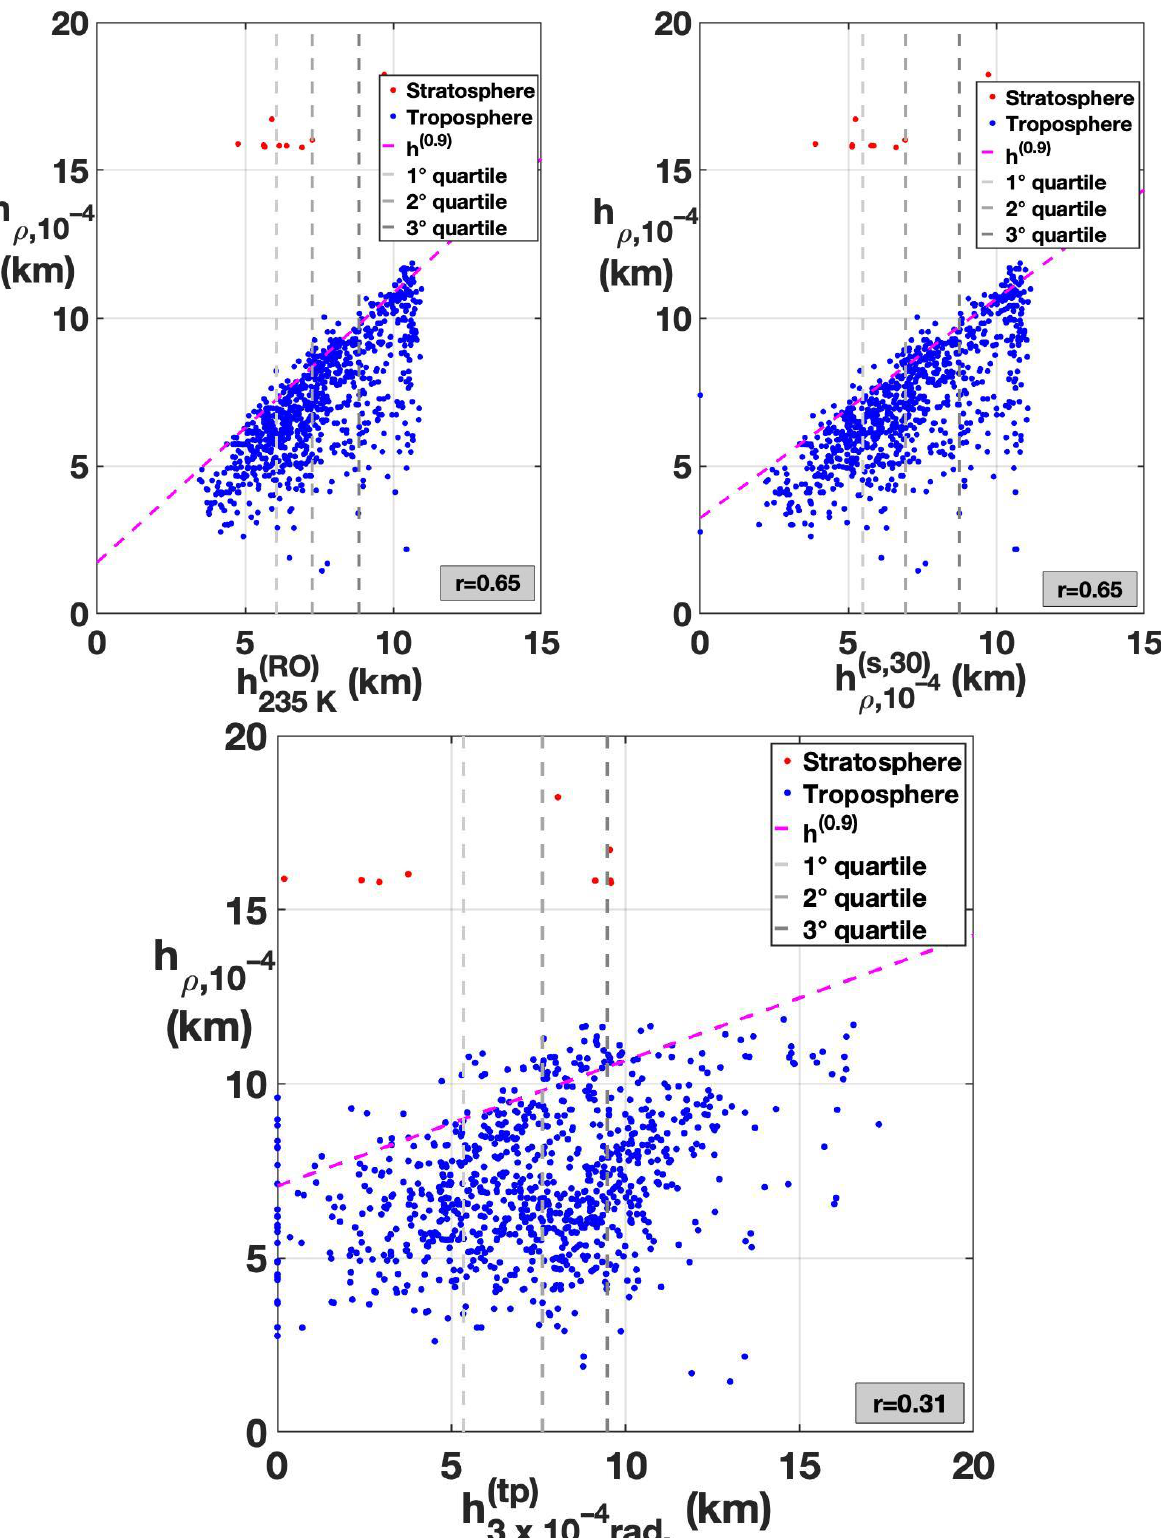
( RO ) ( top left ), 235 K (𝑠,30) 𝐾(𝑅𝑂) ( top left ), ℎ 235 𝜚,10 −4